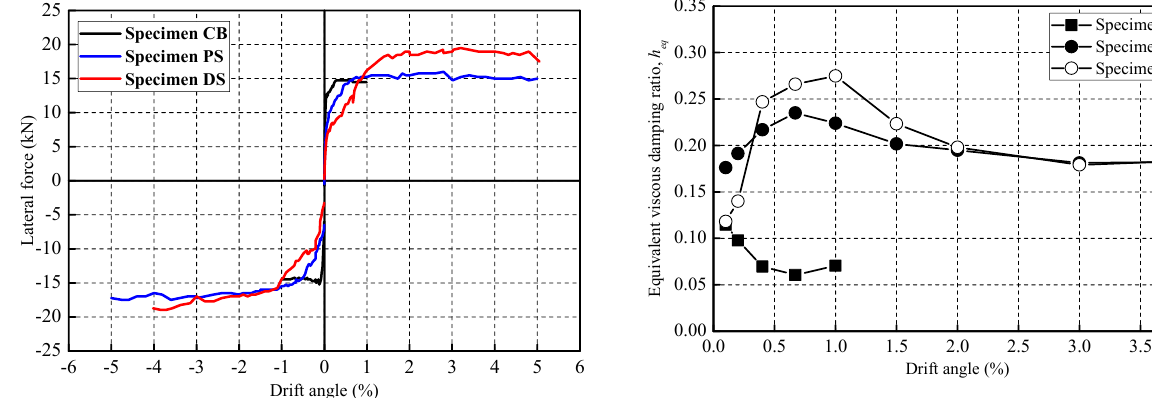
Figure 10. Skeleton curves of each specimen.